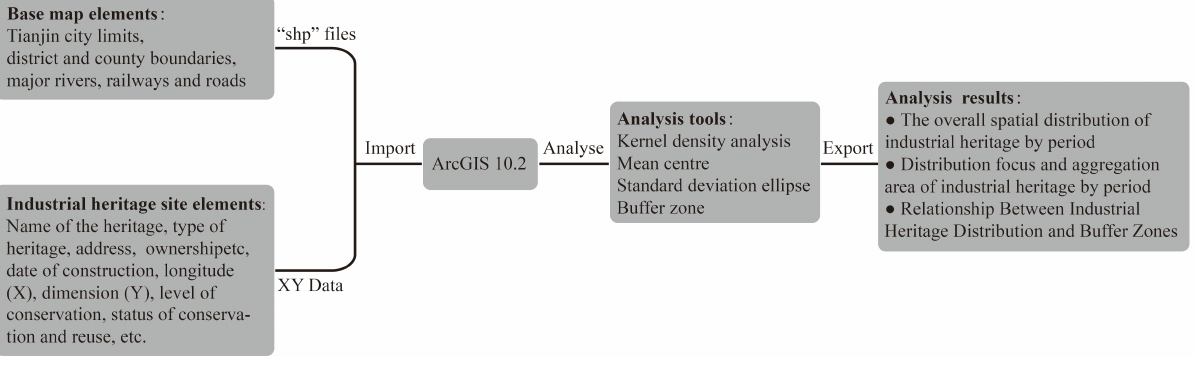
Figure 1. Data analysis